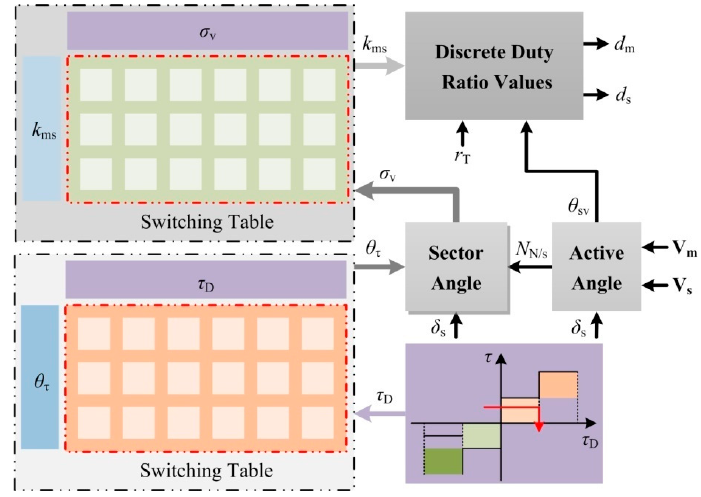
Figure 5. Process of duty ratio discretization.